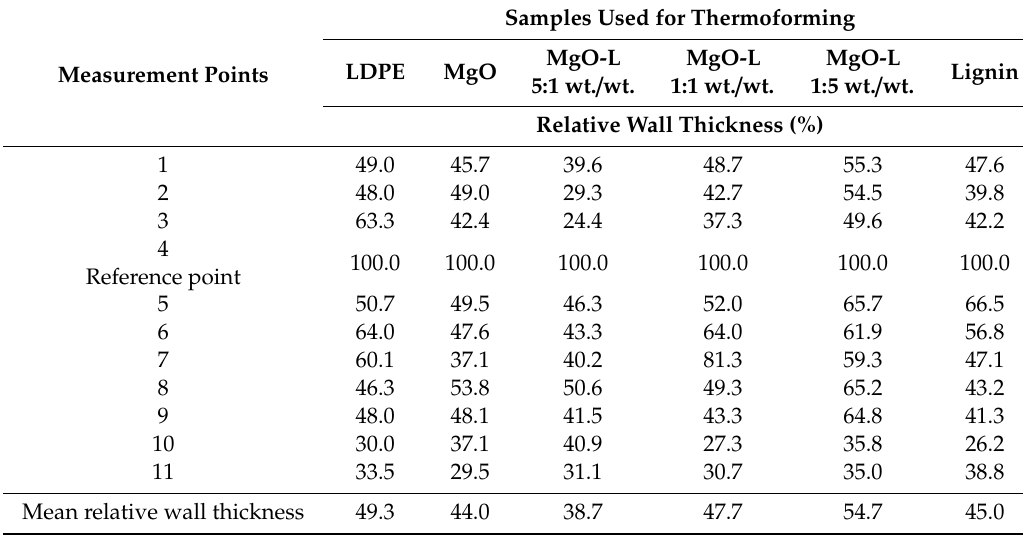
Table 2. Percentage contributions of relative wall thicknesses related to point no.